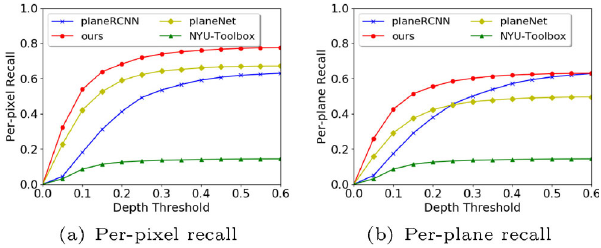
Fig. 3 Comparison between the enhanced SVPNet by our multi-view regularization term and three existing methods for single-view planar scene reconstruction on the ScanNet test